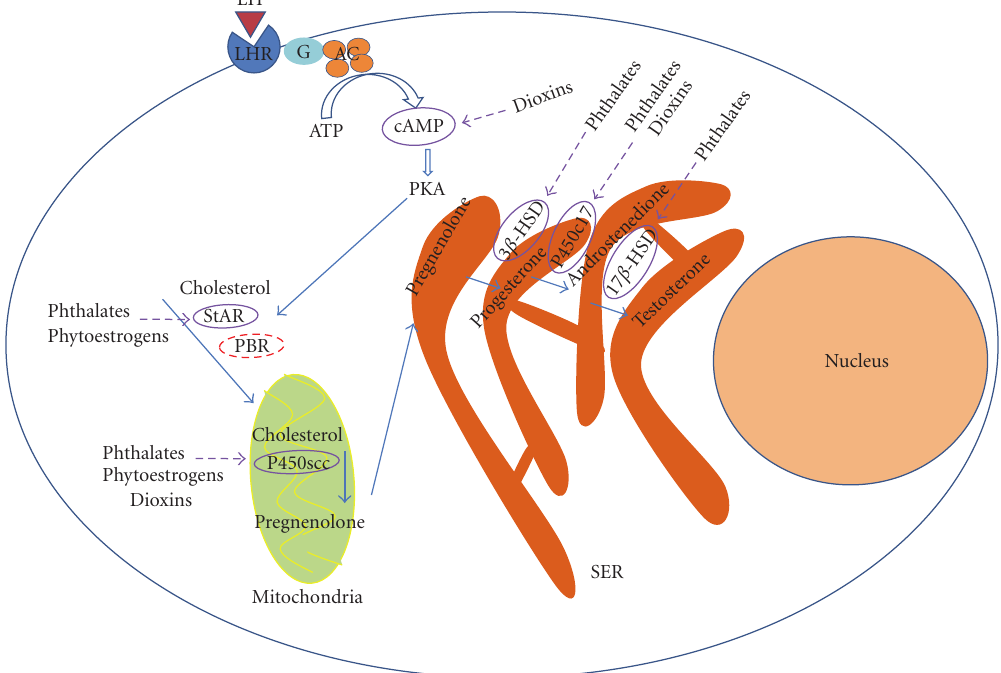
Figure 2: Scheme showing potential sites of action of EDCs on the steroidogenic machinery of Leydig cells. Inhibitory actions of EDCs on androgen biosynthesis by Leydig cells can be exerted via attenuation cAMP-PKA signaling, inhibition of cholesterol transport by the StAR/PBR complex, and suppression of expression and/or activity of di ff erent steroidogenic enzymes (e.g., 3 β HSD, P450scc, P450c17, 17 β HSD). Attenuation of functioning of one or several such target proteins by EDCs may lead to suppression of androgen production by Leydig cells and impairment of androgen-dependent physiological